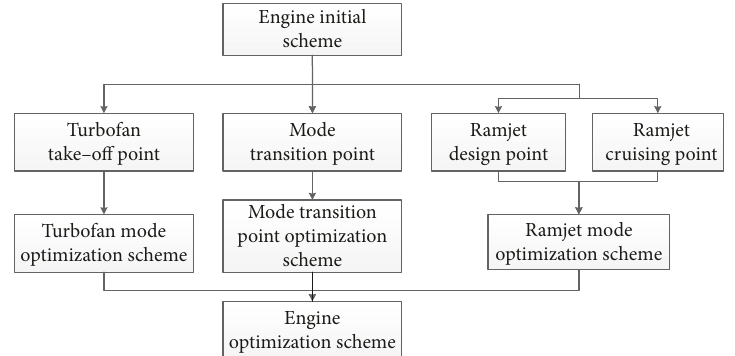
Figure 19: Optimization scheme of the TBCC engine.